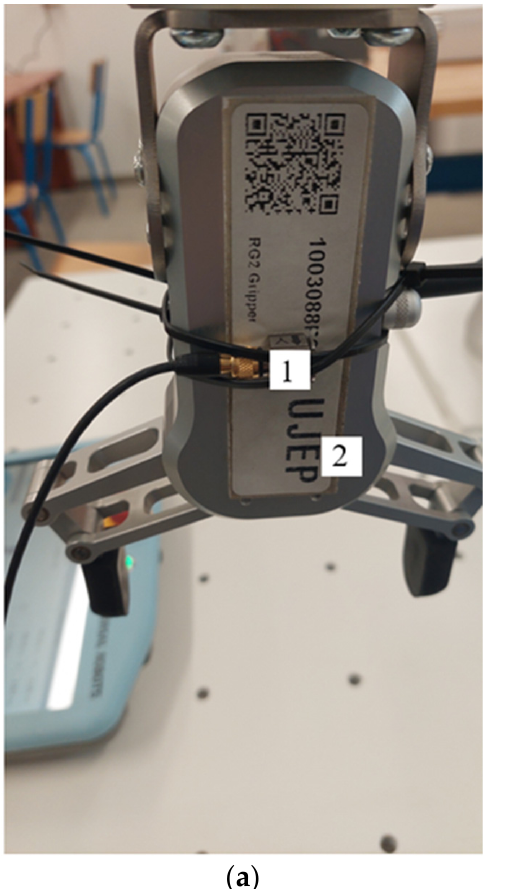
Figure 8. Accelerometer attachment—1 on a two-fingered gripper RG2—2 ( a ), directions of measurement axis on accelerometer ( b ).